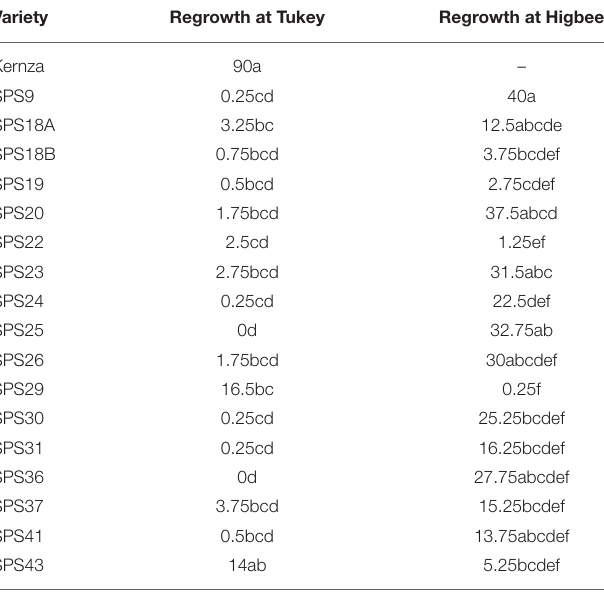
TABLE 10 | Mean winter survival/spring regrowth (% of plants per plot) in the TABLE 9 | Mean autumn regrowth scores for lines exhibiting post-sexual second year for different locations (Higbee and Tukey). cycle regrowth. Variety Reproductive Variety Regrowth at Tukey Regrowth at Reproductive Regrowth regrowth at regrowth at height Tukey Higbee